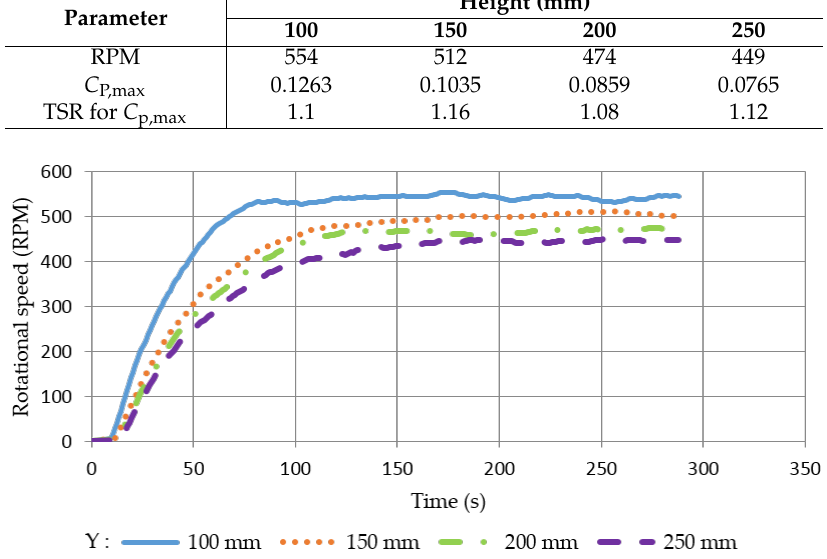
Figure 15. Rotational speed against time for CAWT at various heights above the rooftop.